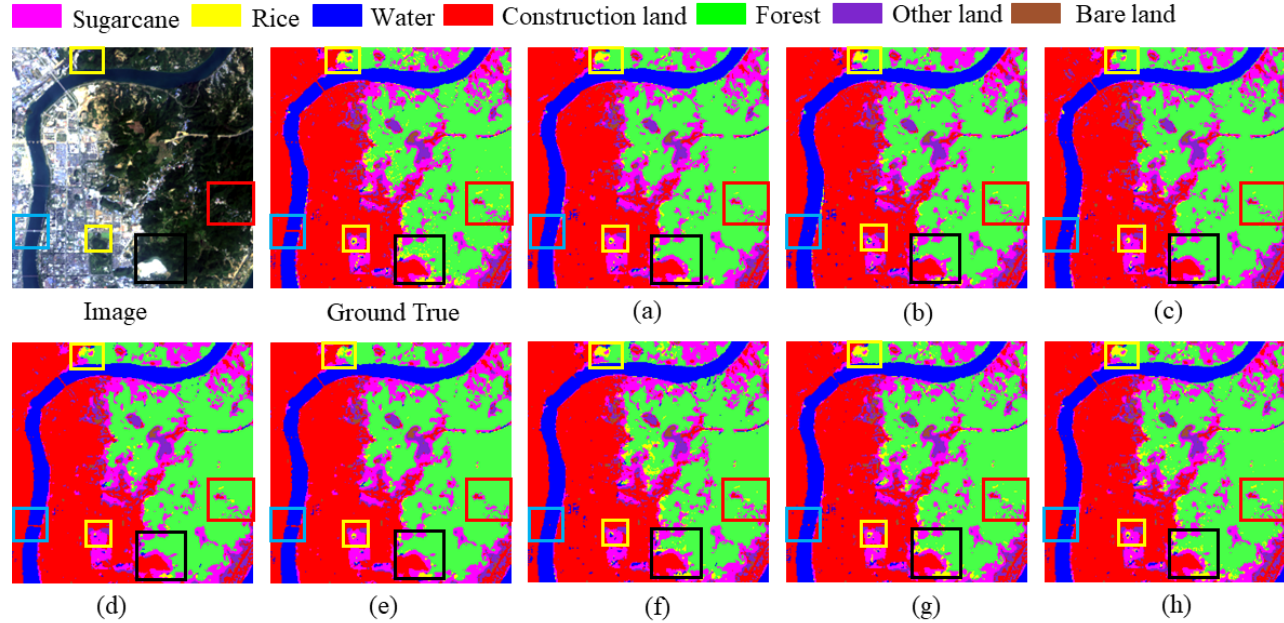
Figure 12. Results of local semantic segmentation on the test set from the dataset I by: ( a ) U-Net, ( b ) U-Net++, ( c ) SAR-UNet, ( d ) Res-UNet++, ( e ) Attention-UNet, ( f ) UCTransNet, ( g ) Swin-UNet, and ( h )